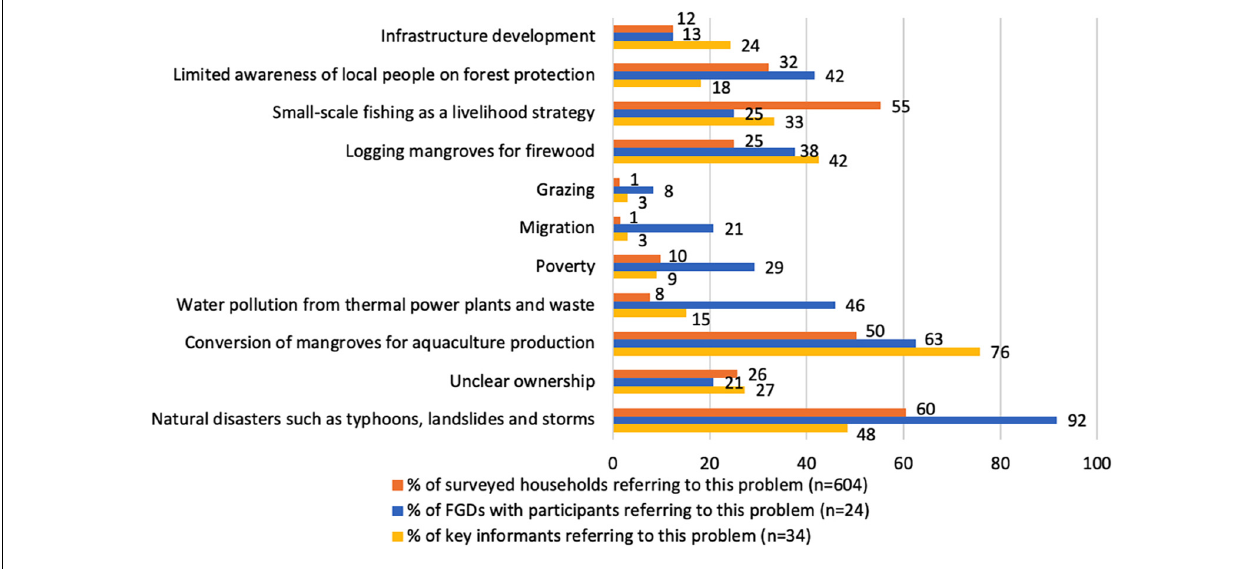
FIGURE 2 | Stakeholder perceptions on the drivers of mangrove deforestation in the six study villages. TABLE 4 | Policies and financial incentives for addressing drivers of mangrove deforestation and